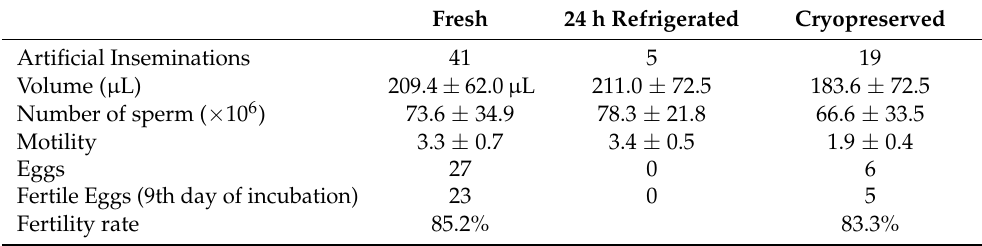
Table 3. Mean parameters of artificial inseminations performed with fresh, 24 h refrigerated and cryopreserved semen. Means are presented along with standard